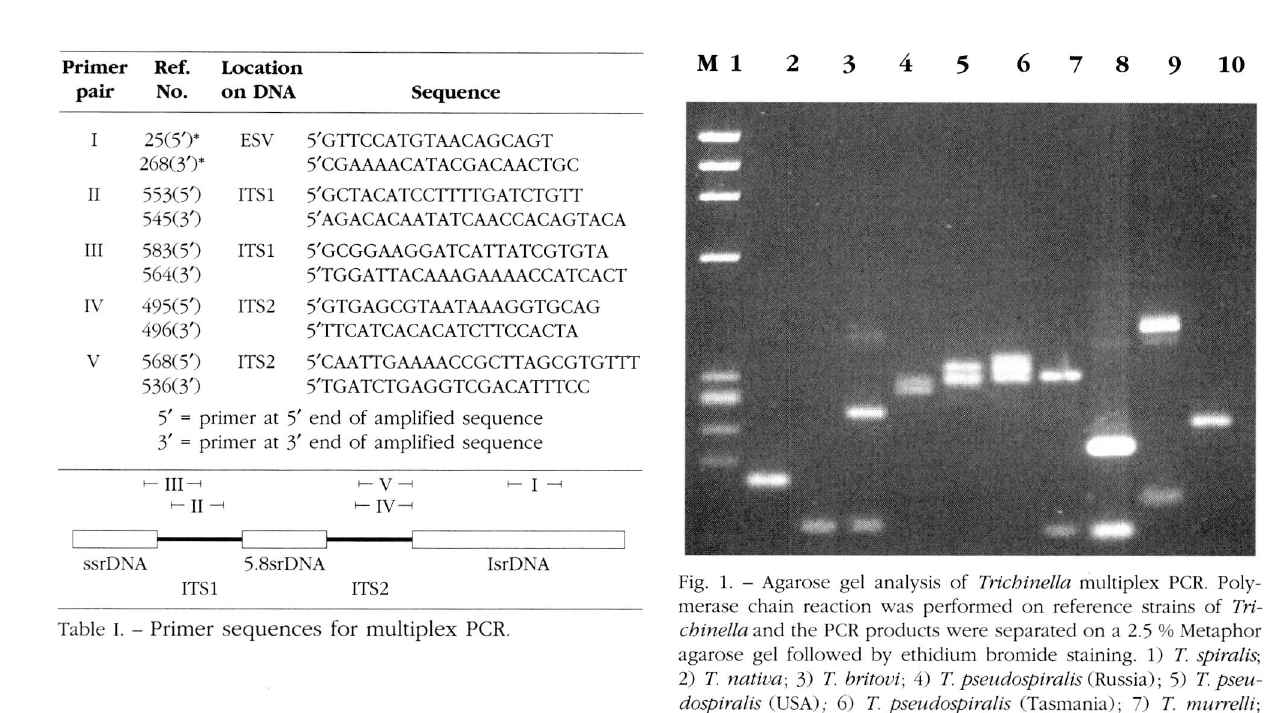
Fig. 1. - Agarose gel analysis of Trichinella multiplex PCR. Poly merase chain reaction was performed on reference strains of Tri chinella and the PCR products were separated on a 2.5 % Metaphor agarose gel followed by ethidium bromide staining. 1) T. spiralis; 2) T. nativa; 3) T. britovi; 4) T. pseudospiralis